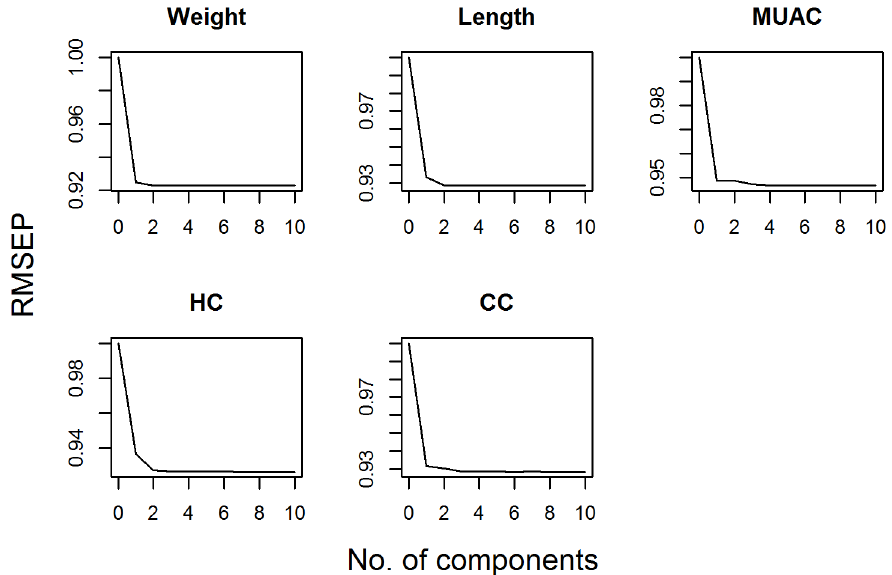
Fig 2. Root mean squared error of prediction (RMSEP) for different number of components of partial least squares (PLS) repression.